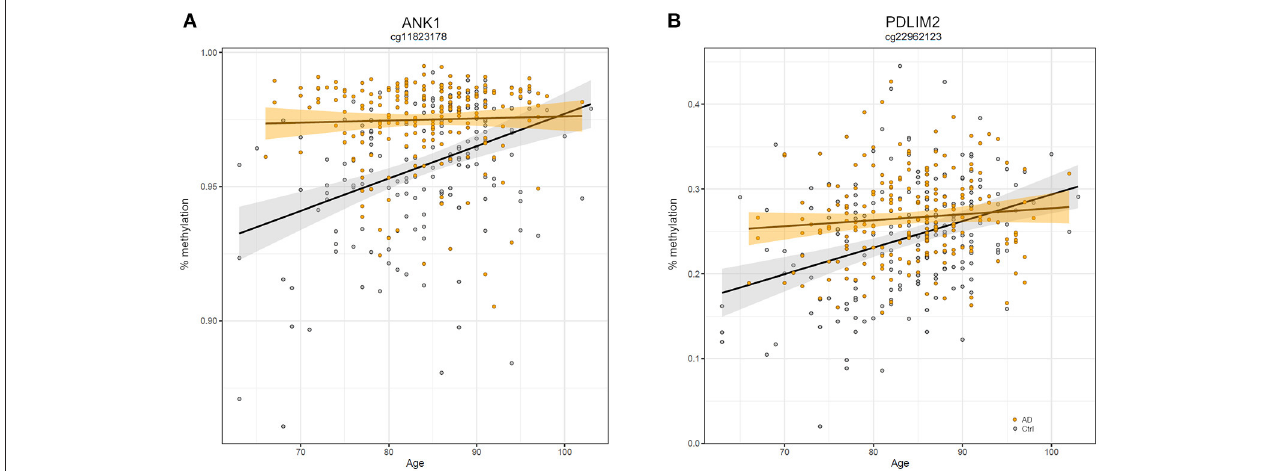
FIGURE 5 | Scatter plots of ANK1 and PDLIM2 DNAm according to age and disease. Scatter plots of methylation values of cg11823178 within ANK1 (A) and of cg22962123 within PDLIM2 (B) in TC from GSE134379 dataset. Healthy subjects are colored in gray while AD patients are in orange. Regression lines and confidence intervals within each group are reported.